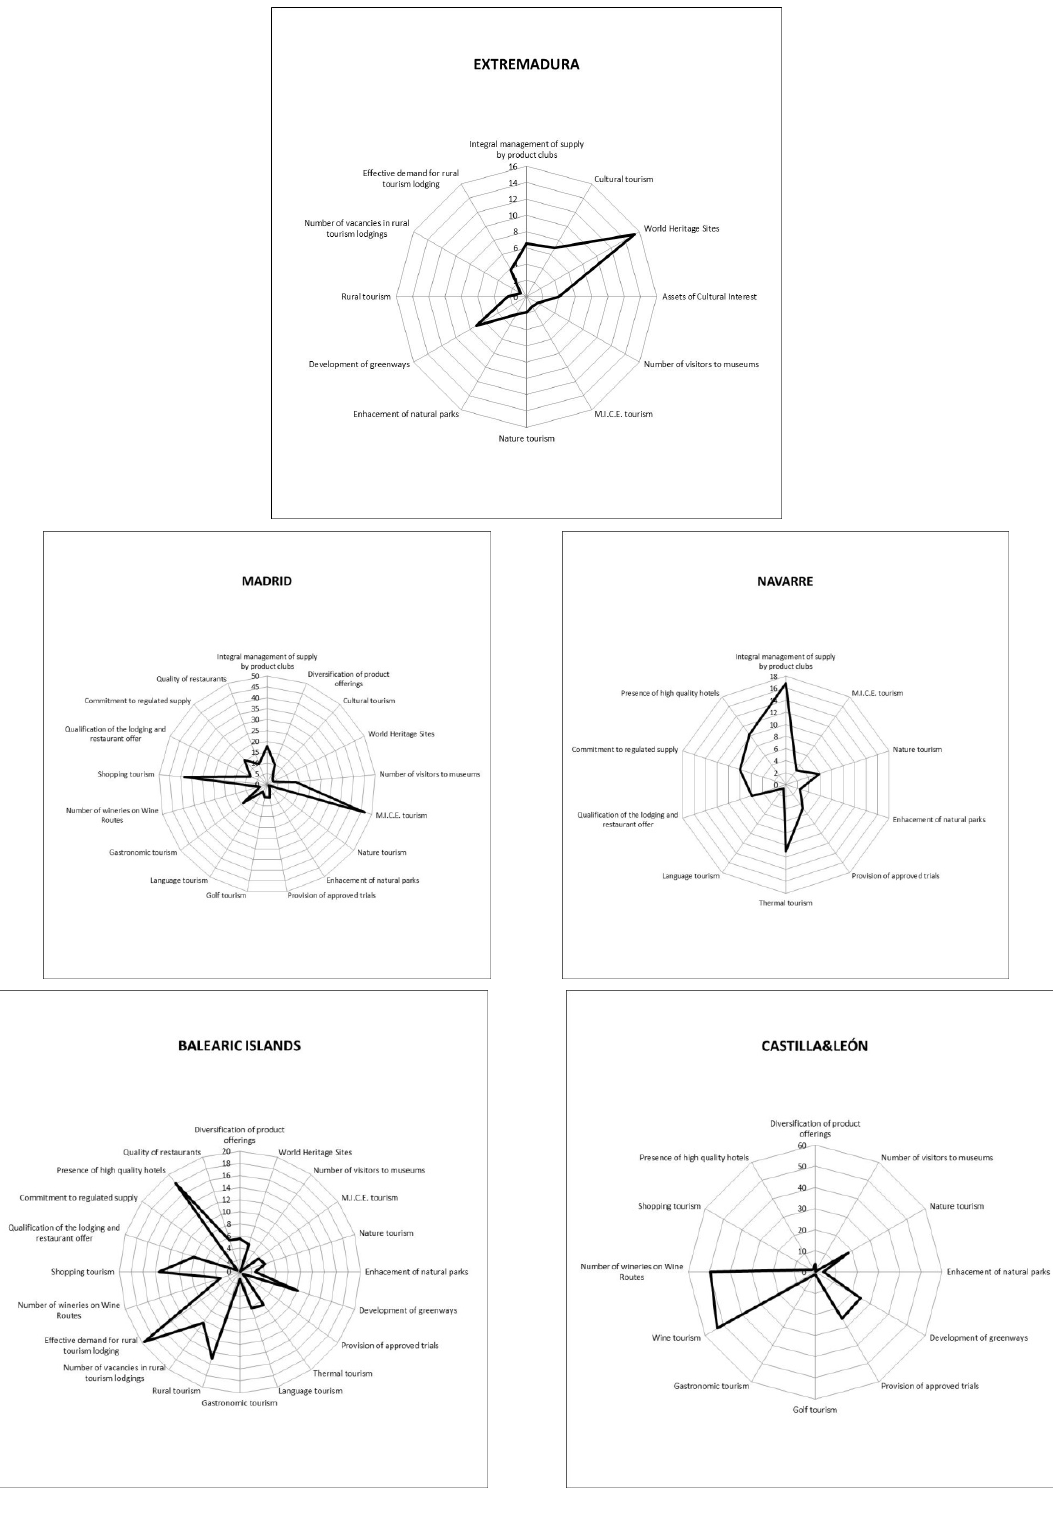
Figure 2. Comparative analysis of the competitive strengthening points and convergences of Extremadura with Madrid, Navarre, the Balearic Islands and Castilla y León. Source: own work.